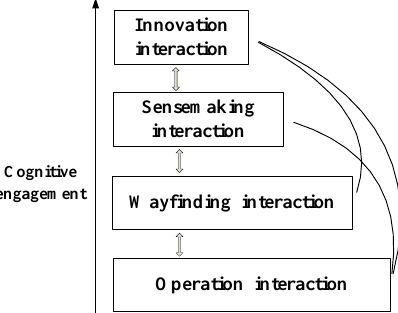
Figure 3. Conceptual framework of interaction for connectivist learning and cognitive